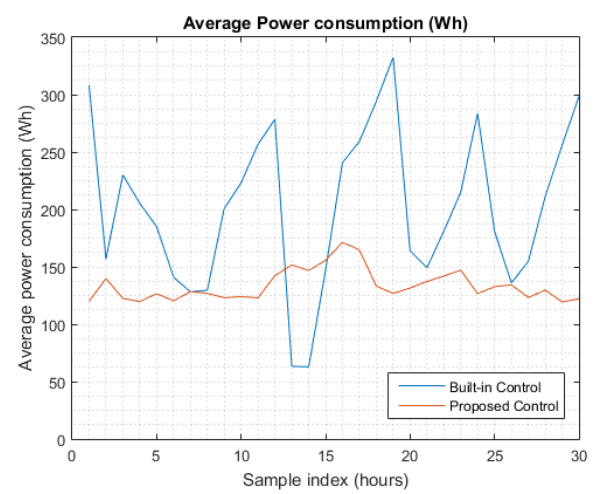
Figure 17. HVAC power consumption with the built-in with 26.58 °C setpoint and the proposed control systems.